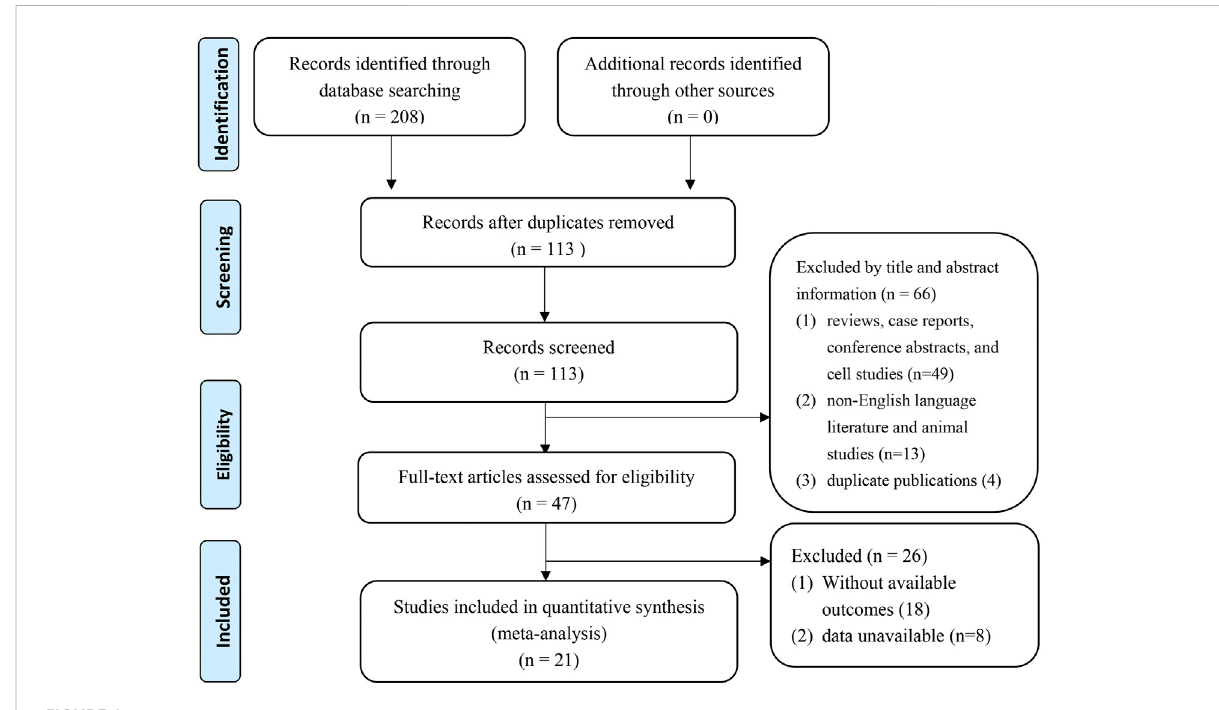
FIGURE 1 Flow diagram of this